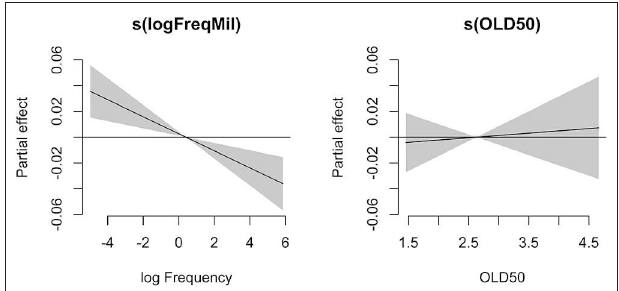
FIGURE 4 | Partial effect estimates from the GAMM model. Left: Effect of frequency on the first keystroke latencies of Suffix-words. Right: (Non-significant) effect of OLD50 (orthographic similarity measure) on the first keystroke latencies of